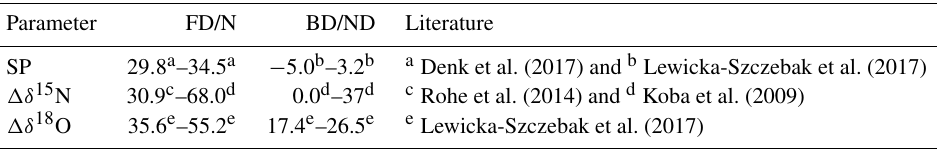
Table 4. Characterization of lower and upper SP, (cid:49)δ 15 N, and (cid:49)δ 18 O boundaries for the two N 2 O-emitting domains fungal denitrification and/or nitrification (FD/N) and bacterial denitrification and/or nitrifier denitrification (BD/ND) according to the literature. All values are given in per mil (‰).